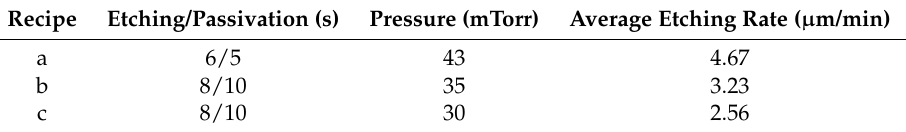
Table 2. Process Parameters of DRIE.